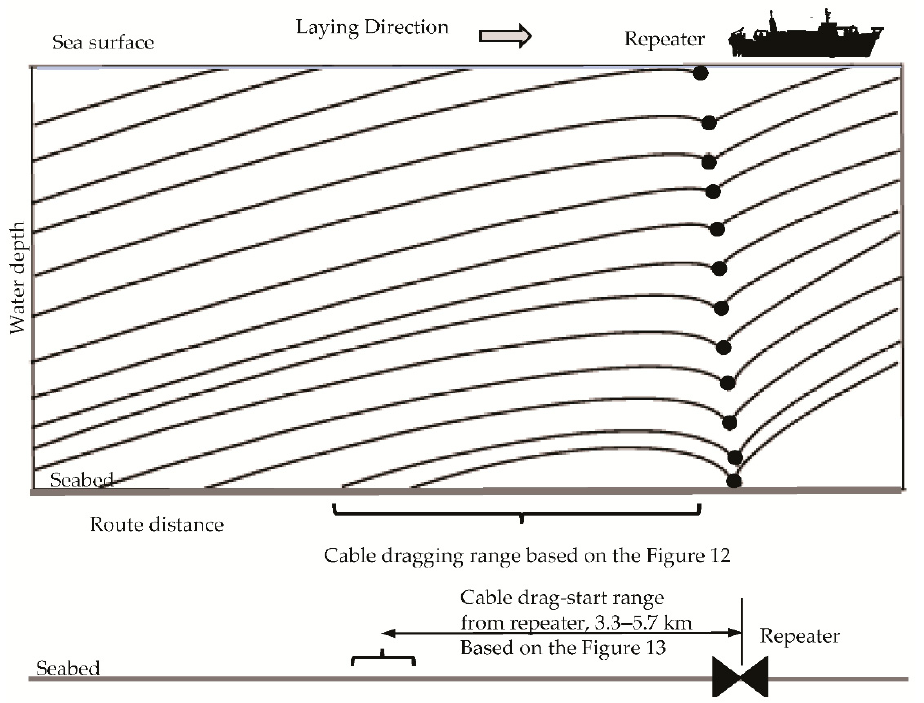
Figure 11. Typical repeater descent situation by simulation, upper; the cable drag-start range from the repeater on the seabed, lower.